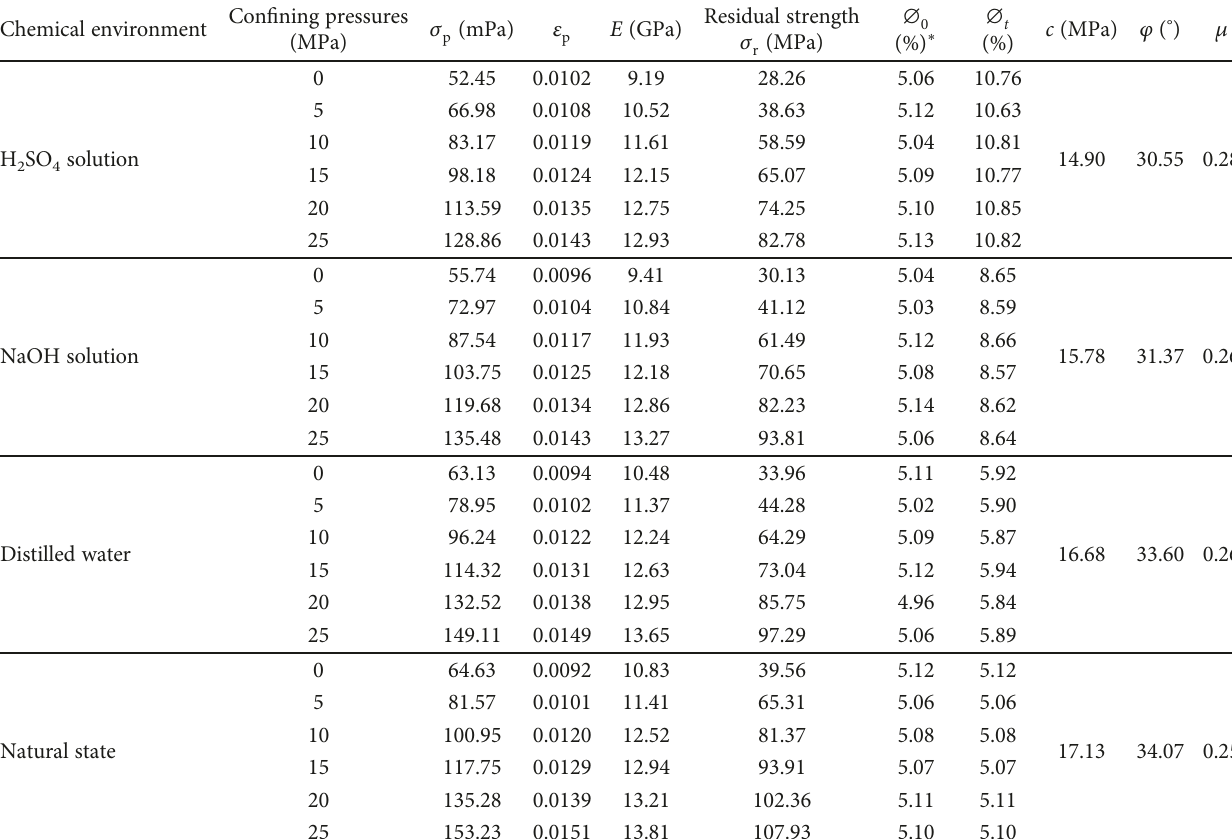
Table 1: Parameters of sandstone under the conditions of di ff erent chemical